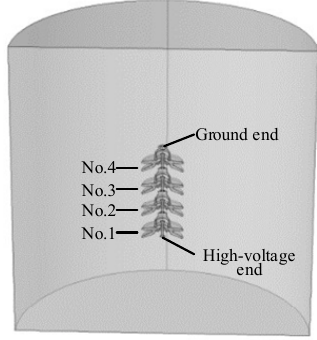
Figure 3. Structural characteristics of insulators.